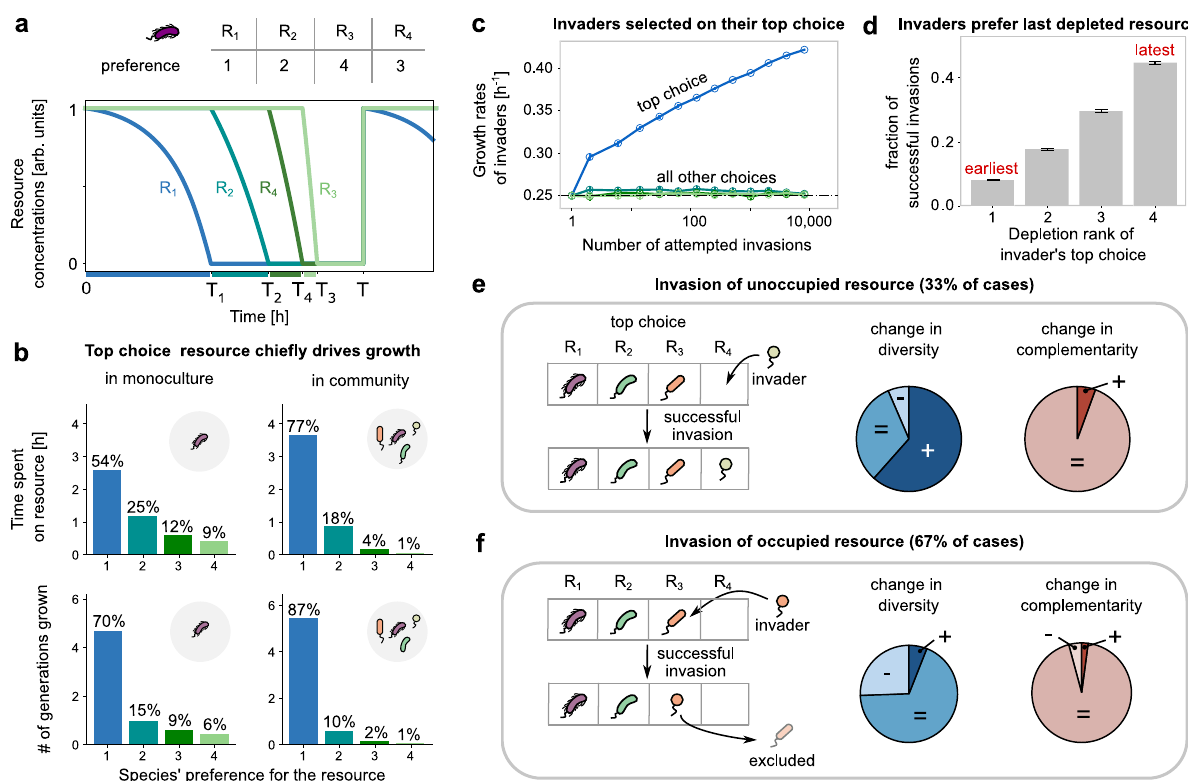
Fig. 3 Top choice resources chie fl y drive community diversity and complementarity. a (top) Table showing the preferences of a diauxic microbial species (purple) for 4 resources, R 1 to R 4 . (bottom) Plots showing the depletion of the 4 resources by the purple species during one serial dilution cycle, when grown alone in our model. b (top) Bar plots showing the time taken by the purple species in ( a ) to grow on each of the 4 resources. Percentages on each bar represent the fraction of time spent growing on each resource. (bottom) Bar plots showing the number of generations grown, or the number of doublings by the species when growing on each resource. In both cases, the plots on the left show the quantities when the purple species is in monoculture (growing alone), and those on the right show them when the purple species is in a community with 3 other species. c Mean growth rates of successful invaders during community assembly. The blue line corresponds to the invader ’ s top choice, while the other colors correspond to all other choices. The horizontal dashed line shows the mean growth rate of the species pool. Each quantity represents a moving average from 958 independent community assembly simulations. Error bars represent s.e.m. d Fraction of the successful invasions as a function of the order in which the invader ’ s top choice resource is depleted, 1 indicating cases where the invader prefers the earliest depleted resource, and 4 where it prefers the last depleted resource. Each bar represents the mean of such a fraction over 958 independent community assembly simulations, and error bars represent s.e.m. e , f Effect of invasions of community diversity and complementarity, based on whether the invader ’ s top choice was ( e ) unoccupied or ( f ) occupied. Cartoons show the typical effect of an invasion. Pie charts show the fraction of invasions that increase, decrease or maintain a community ’ s species diversity (middle) and complementarity (right). On unoccupied resources, diversity typically increases (62%), but sometimes stays constant (32%) or decreases (6%). On occupied resources, diversity typically stays the same (68%), but sometimes decreases (26%) and rarely increases (6%). In almost all cases complementarity either stays maintained or increases (>95%), and very rarely decreases (<5%). Source data are provided as a Source data fi